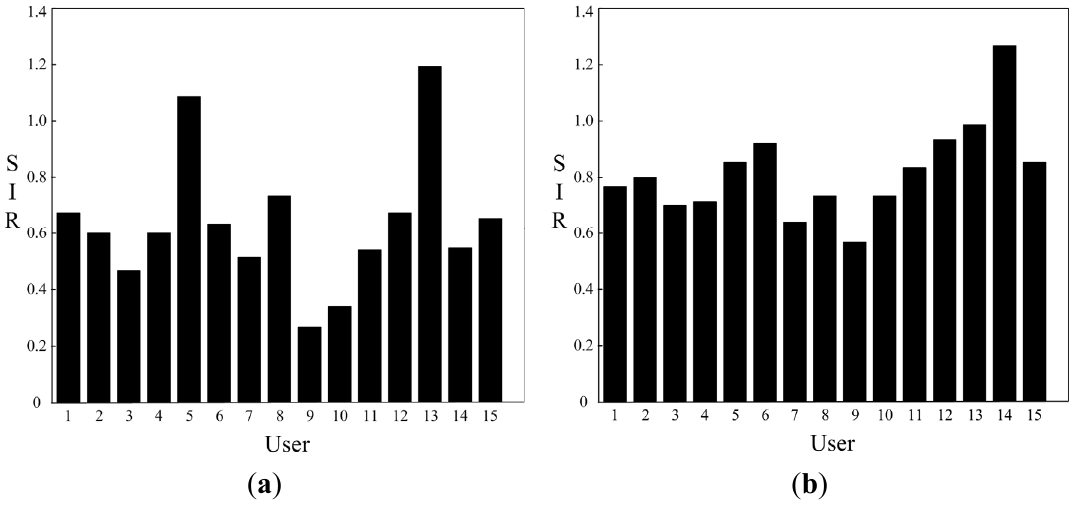
Figure 11. ( a ) The signal to interference ratio (SIR) value before algorithm execution; ( b ) The SIR value after algorithm execution.